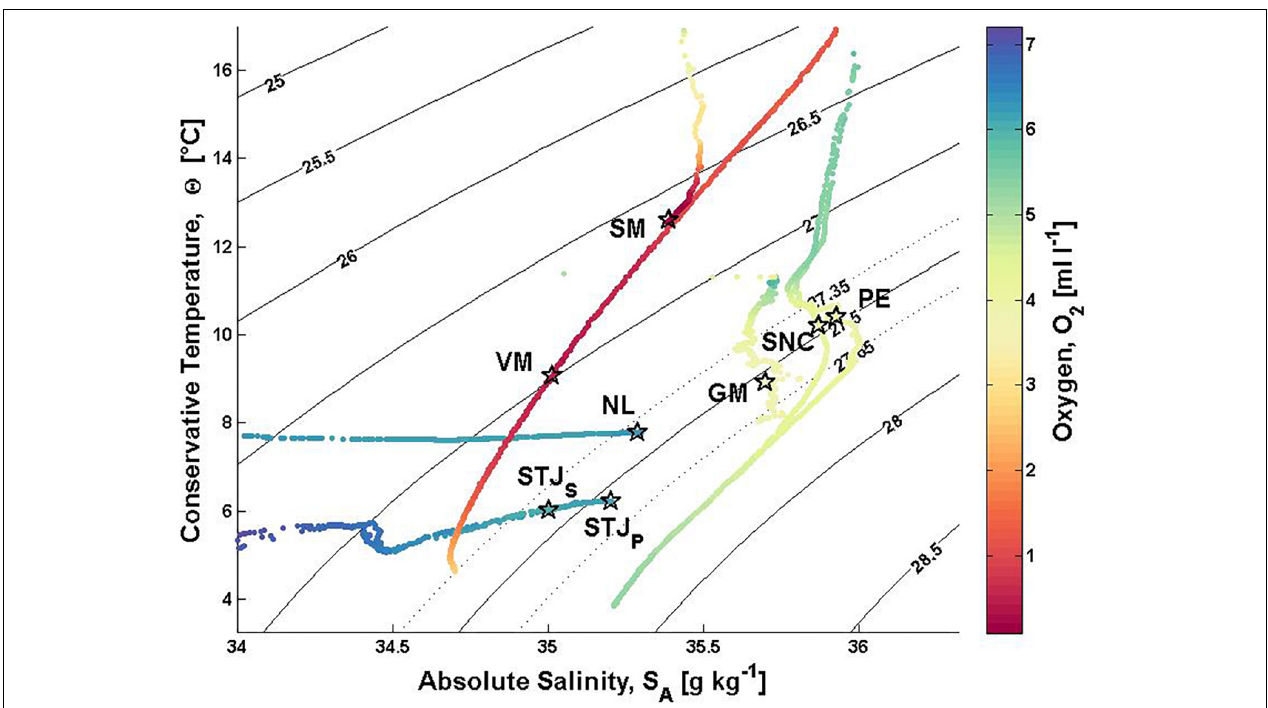
FIGURE 5 | Water column (cid:50) S A -O 2 plot. The sigma-theta range of 27.35–27.65 kg m - 3 from Dullo et al. (2008) marked with dotted lines. The lander positions relative to water columns are marked with stars. STJ S , Stjernsund CWCs; STJ P , Stjernsund reference; NL, Nordleksa; GM, Galway Mound; SNC, St. Nazaire Canyon; PE, Pagés Escarpment; VM, Valentine Mound; SM, Sylvester